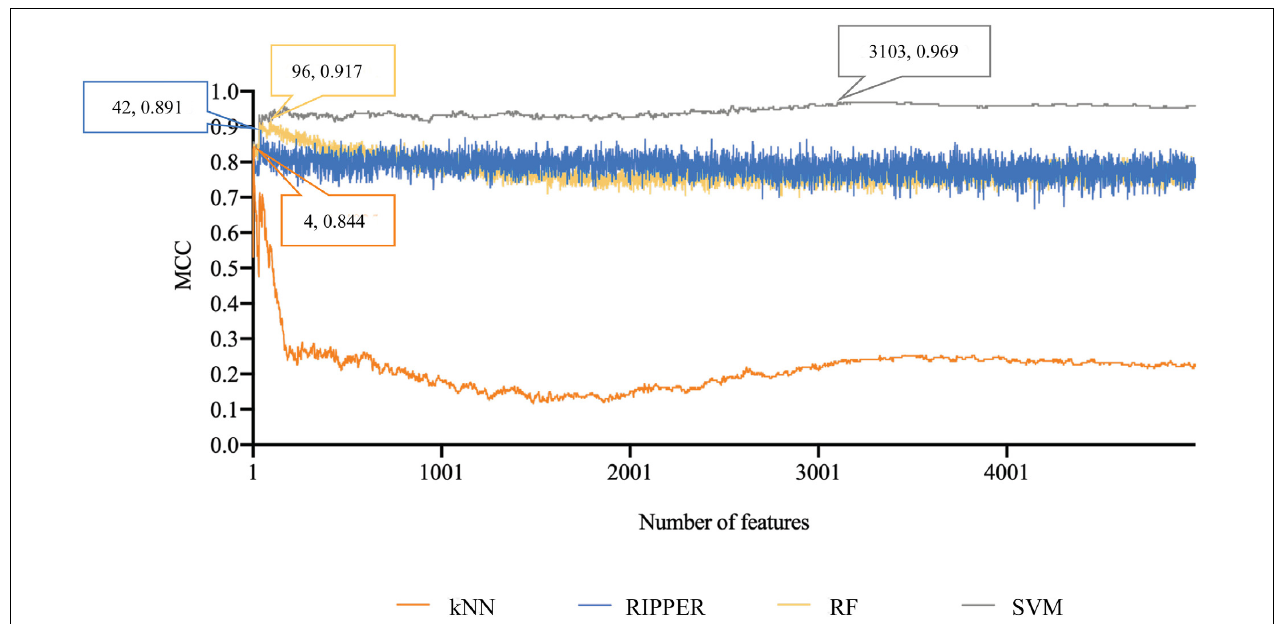
FIGURE 5 | Performance curves of IFS with RF, SVM, kNN, and RIPPER under different numbers of features for combined data. SVM produces the highest MCC of 0.969.